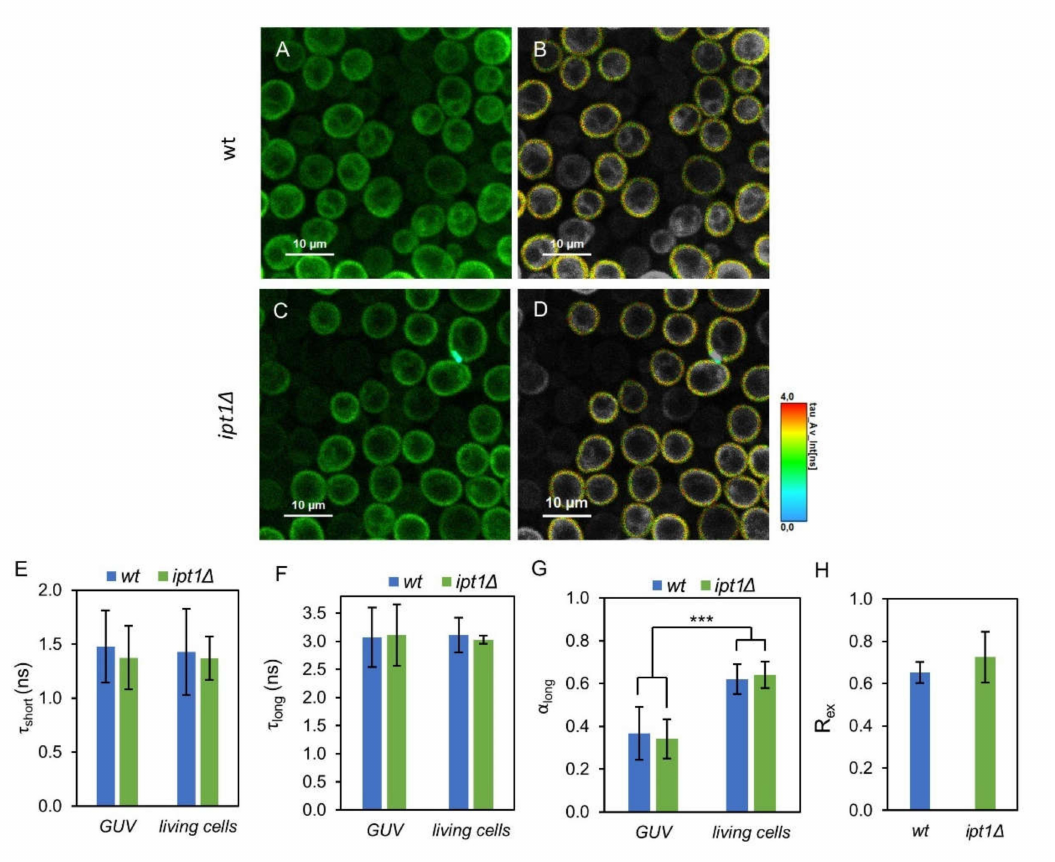
Figure 4. Di-8-ANEPPS parameters are identical for wt and ipt1 ∆ cells in the di ff erent systems studied. Representative fluorescence lifetime imaging microscopy (FLIM) images of living S. cerevisiae wt ( A , B ) and ipt1 ∆ cells ( C , D ) labelled with di-8-ANEPPS. Panels ( A , C ) show representative intensity images, whereas in panels ( B , D ) the region-of-interest (ROI) selecting the plasma membrane is represented with the lifetime color scale obtained by FLIM. Lifetime components in GUVs obtained from plasma membrane lipids of wt and ipt1 ∆ cells and in living cells, ( E ) lifetime of the short component, ( F ) lifetime of the long component and ( G ) amplitude of the long component. The amplitude of the short component is 1- α long . The values are the mean ± S.D. of at least three biological replicates with a total of at least 50 GUVs and 400 cells analyzed per strain. ***, p ≤ 0.001. In panel ( H ) R ex (420 nm / 520 nm), which is linearly dependent on the membrane dipole potential, is shown for IPM suspensions labeled with di-8-ANEPPS ( n ≥